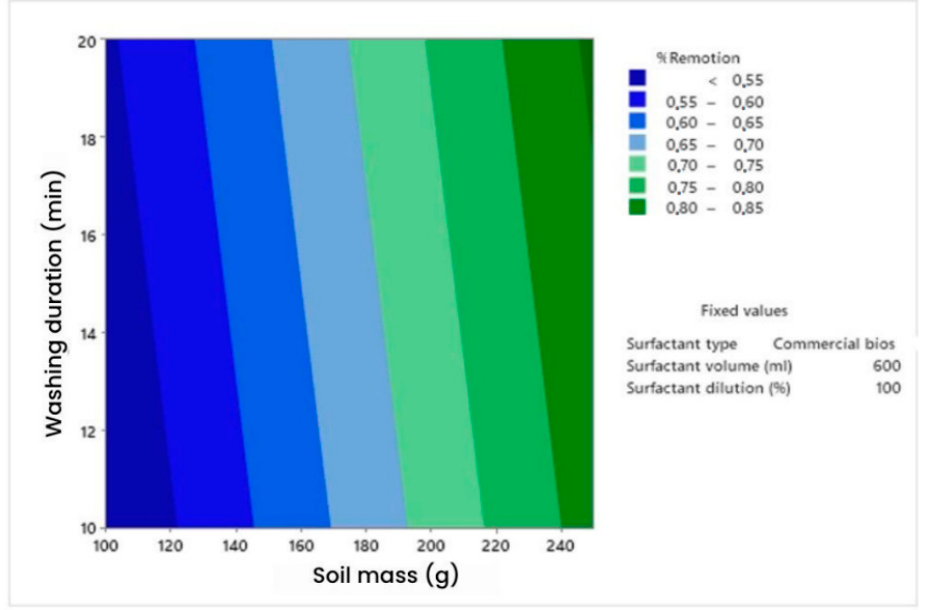
Figure 5. Contour plot of oil removal (%) vs Soil mass (g) and Washing duration (min).